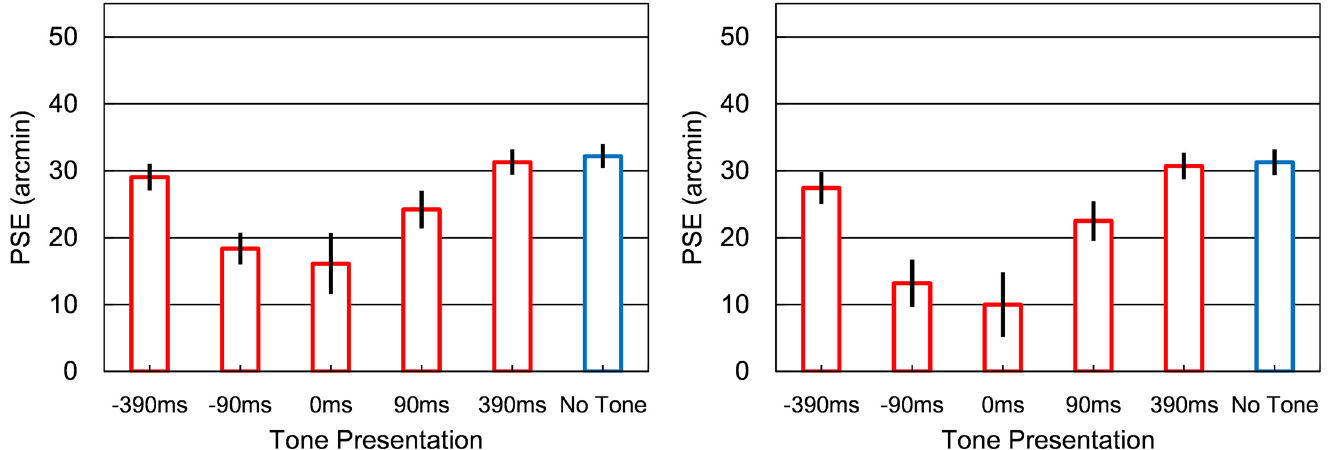
Fig 3. Results of Experiment 2. Group mean PSEs for tone conditions in the (a) overlap and (b) directional change judgment tasks. Error bars denote standard errors of the mean ( n =